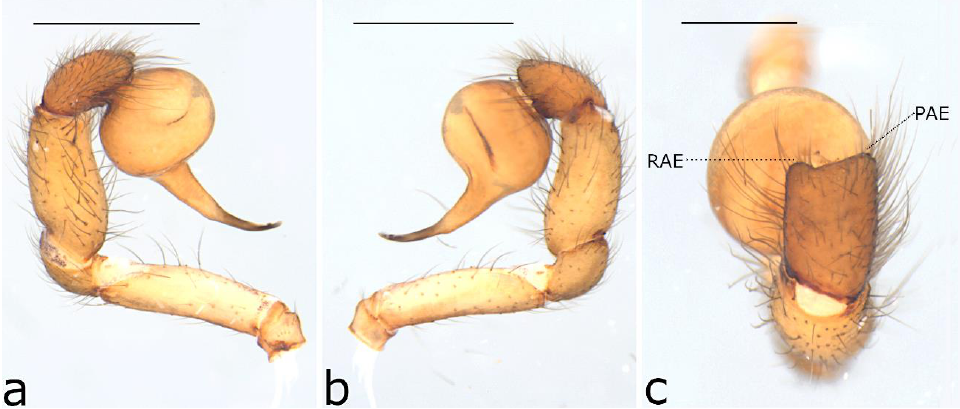
Figure 23. Ariadna umbra sp. nov. ♂ holotype (SAMA NN30621) from Naracoorte (SA): ( a ) left ped- ipalp, prolateral view; ( b ) same, retrolateral view; ( c ) same, cymbium. Scale bar ( a , b ) = 1 mm and ( c ) = 0.5